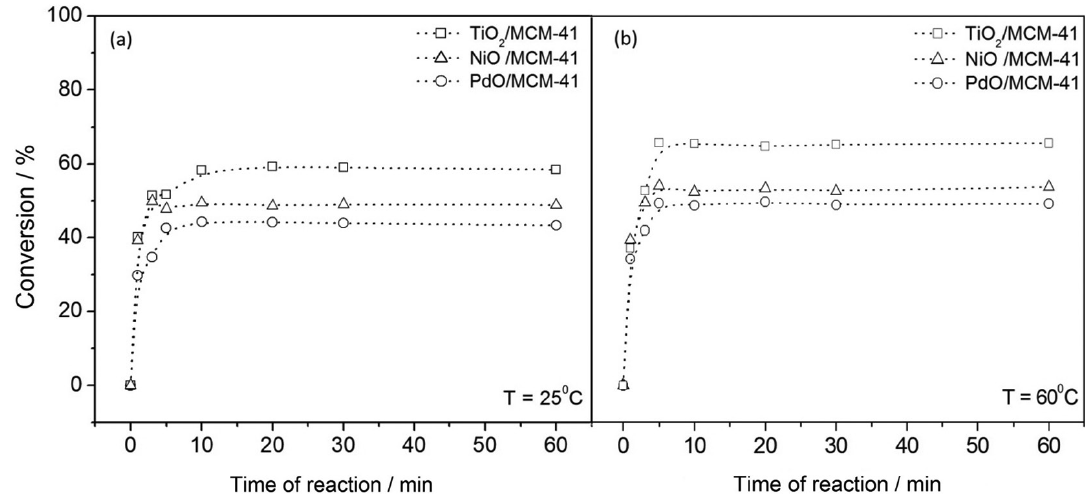
Figure 5. Catalytic test for the oxidative desulfurization reaction at (a) 25 °C and (b) 60 °C of the NiO/MCM‑41, PdO/MCM‑41 and TiO 2